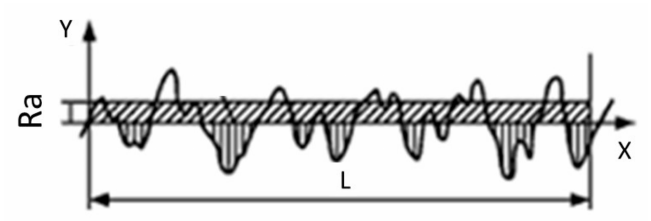
Figure 2. General profile measurement result